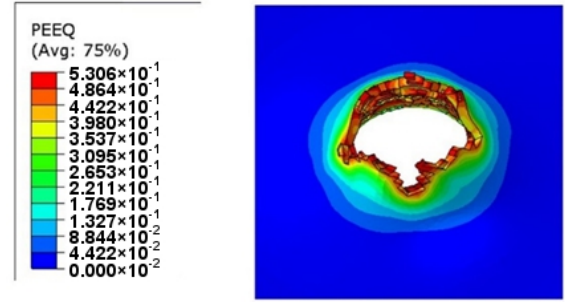
Figure 27. PEEQ visualization for three layers of titanium alloy.